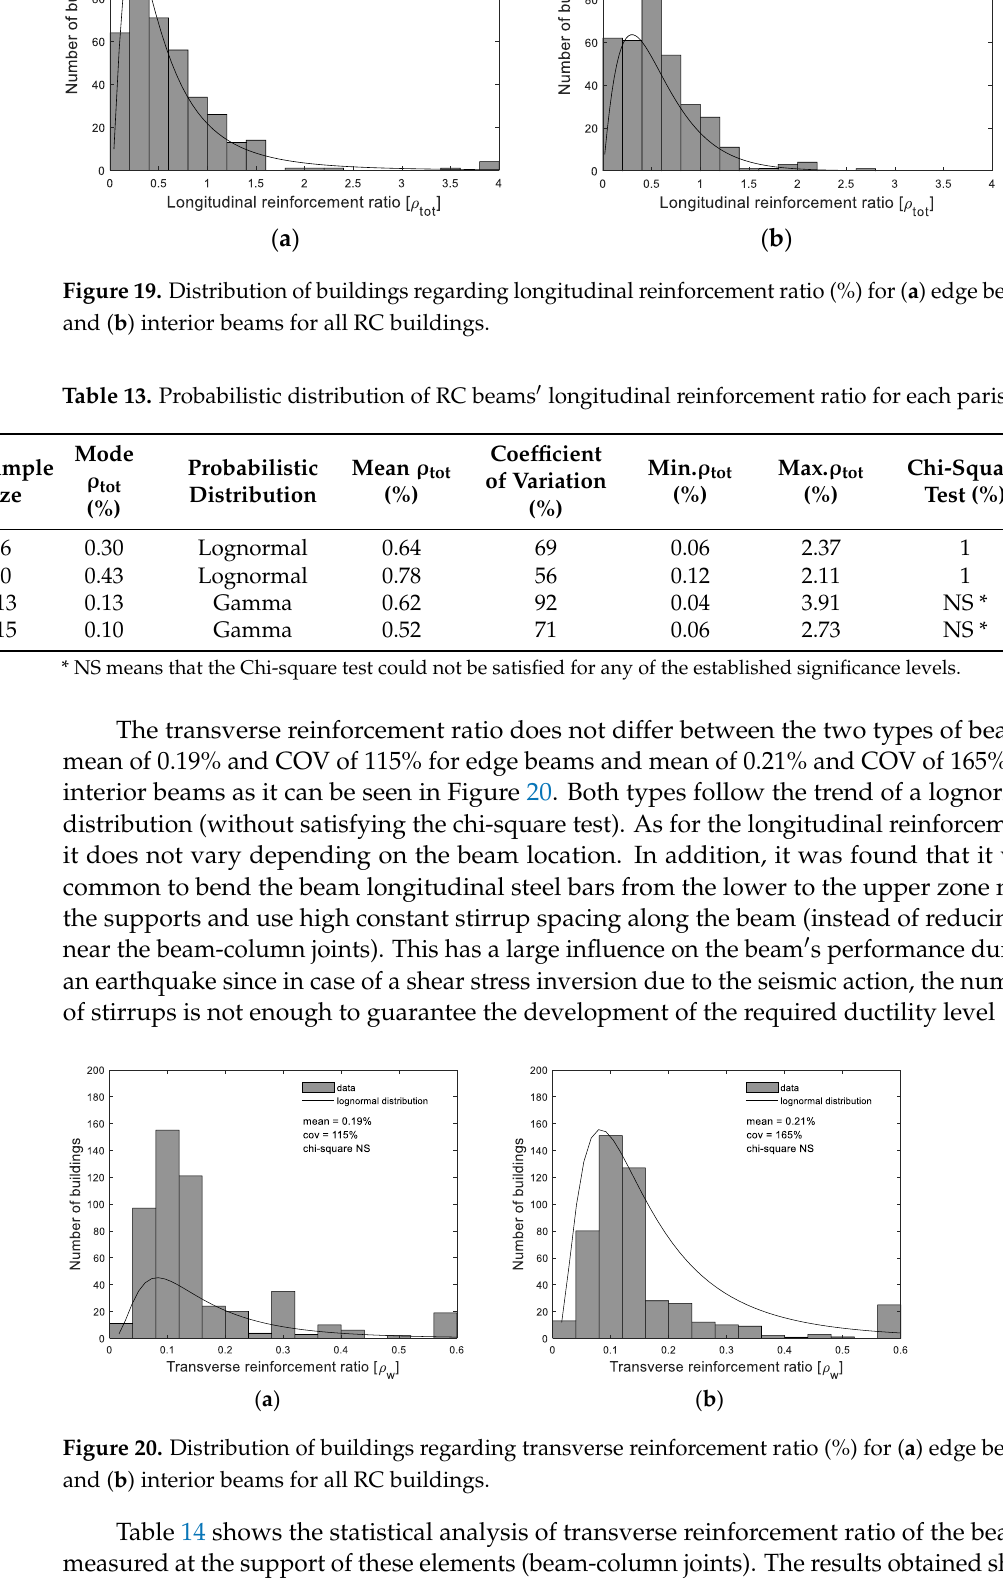
Table 14. Probabilistic distribution of RC beams′ transverse reinforcement ratio for each parish. Type